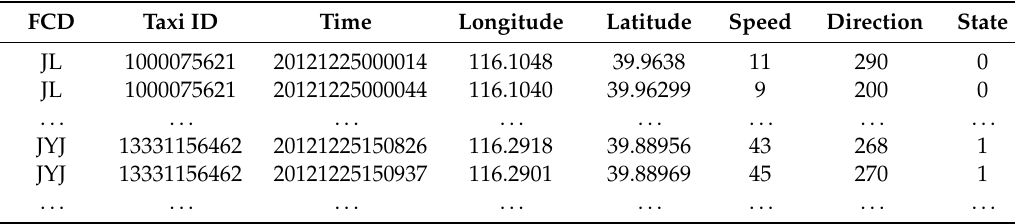
Table 1. GPS data in Beijing